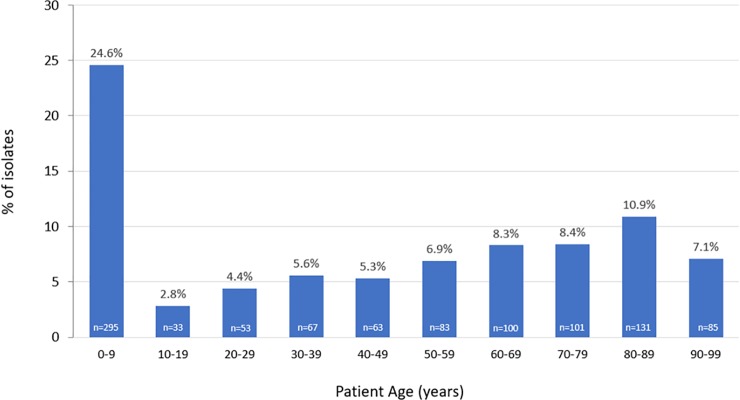
Proportion of conjunctival isolates collected in the ARMOR study, stratified by patient age.Missing: n = 187 (15.6%).